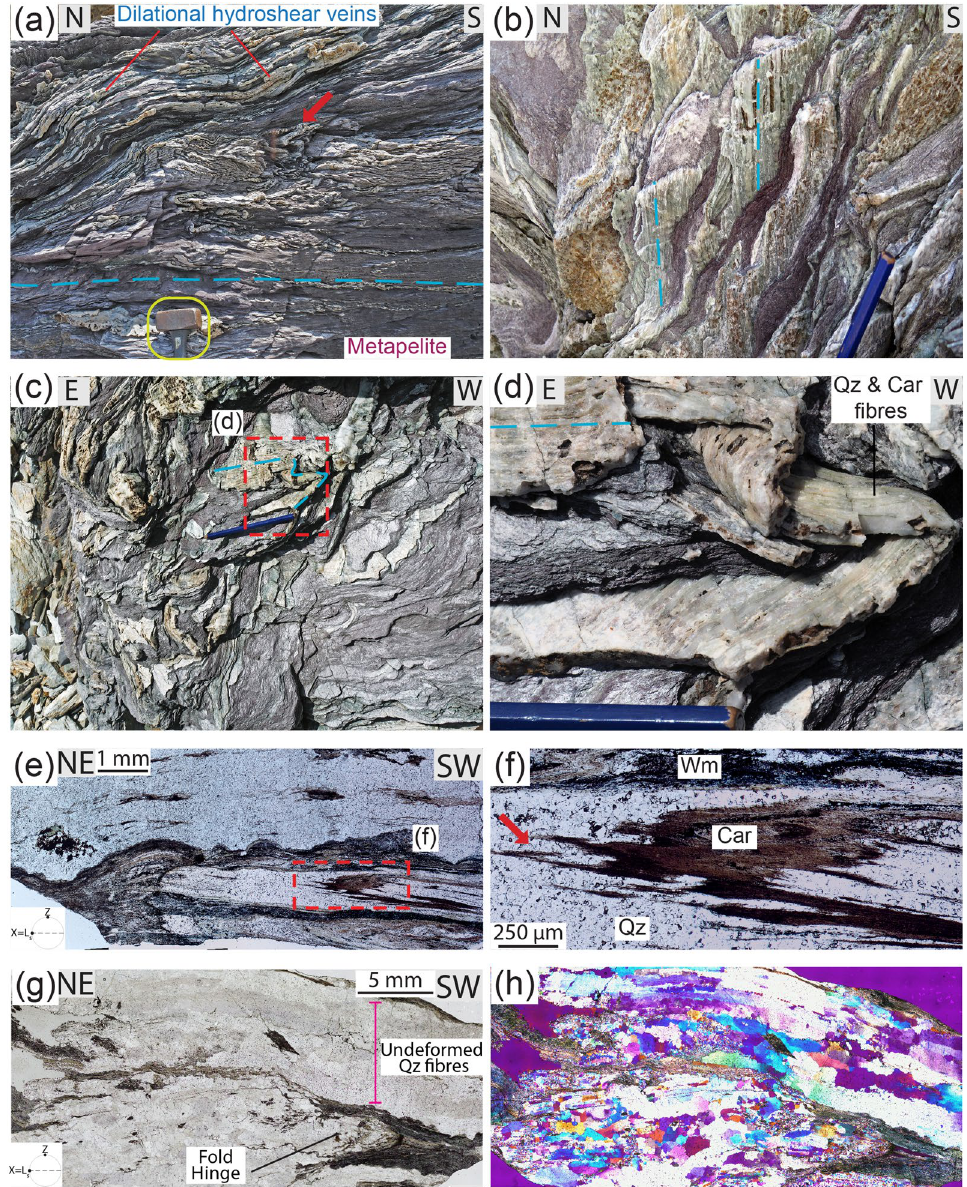
Figure 5. Metapelite with blueschist facies foliation and folded quartz and carpholite dilational hydroshear veins. ( a ) View perpendicular to the foliation. The light blue dashed line indicates the trace of the blueschist facies foliation, the red arrow highlights a fold hinge; yellow circle: hammer for scale. ( b ) View parallel to foliation planes with iso-oriented quartz and carpholite fibres in hydroshear veins (light blue dashed lines). ( c , d ) Detail of non-cylindrical folding of dilational hydroshear vein with quartz and carpholite fibres up to 10 cm long. ( e , f ) Thin section photos of dilational hydroshear vein with fold defined by white mica-rich bands. The red arrow in ( f ) points at carpholite grains in the hinge zone oriented parallel to the axial plane of the fold. Plane- polarized light. ( g , h ) The thin section is composed of an isoclinal fold surrounded by phengitic muscovite bands (bottom) and almost undeformed quartz fibres some centimetres long with undulose extinction (top part). Plane- and crossed-polarized light with gypsum plate inserted,